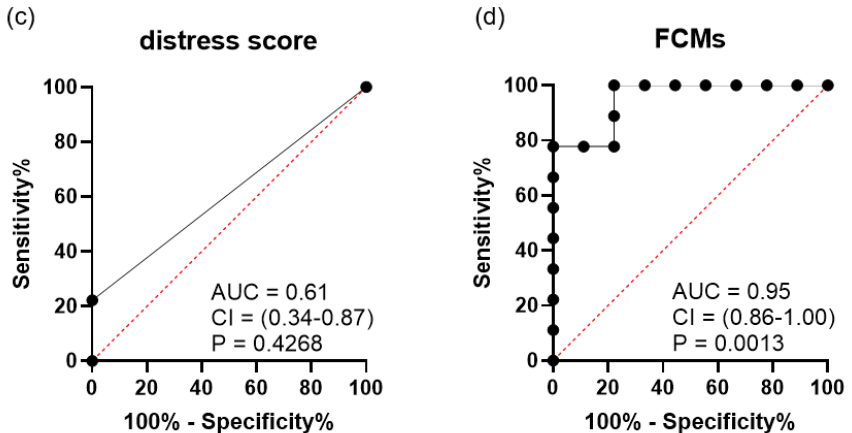
Figure 3. Diagnostic ability of distress parameters when differentiating between mice before cancer cells were injected and identical mice bearing A-375 tumors in the late phase (n = 9). ROC curve analysis of ( a ) percentage of body weight change, ( b ) burrowing activity, ( c ) distress score, ( d ) con- centration of faecal corticosterone metabolites (FCMs). The area under the curve (AUC), the 95% confidence interval (CI) and the P-value (P) for testing the AUC to be 0.5 are presented in each graph.